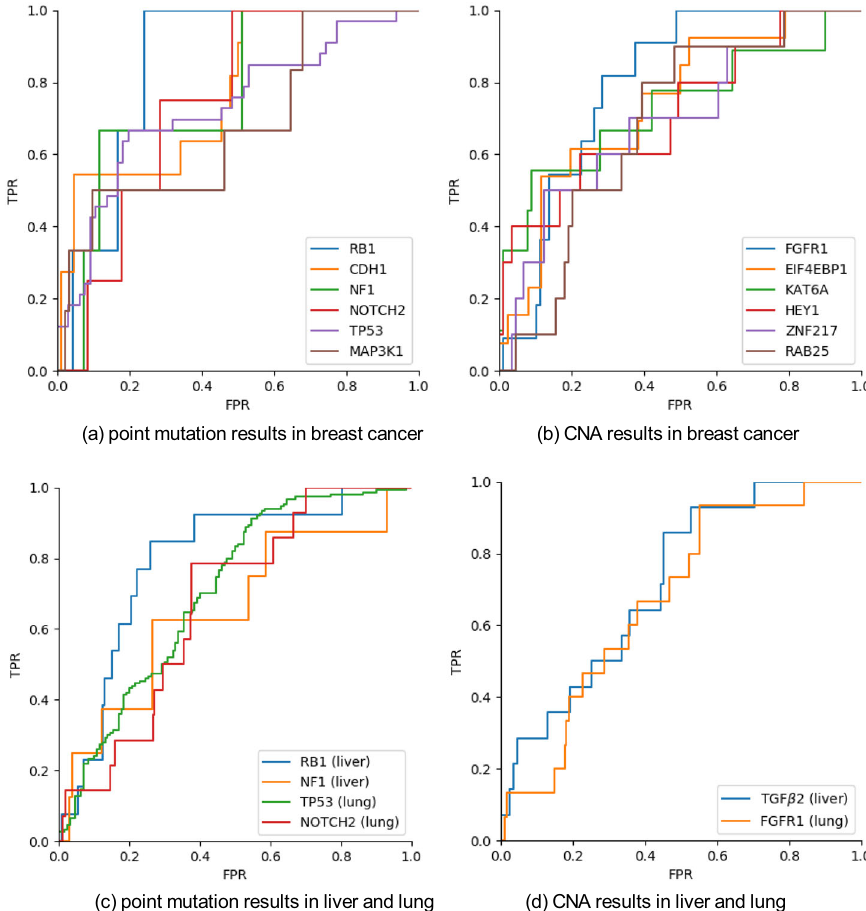
Fig. 2 ROC curves of the top prediction outcomes. Results include ( a ) top point mutations and ( b ) top CNA predictions in breast cancer. Also ( c ) and ( d ) provide the associated validation results on point mutation and CNA predictions